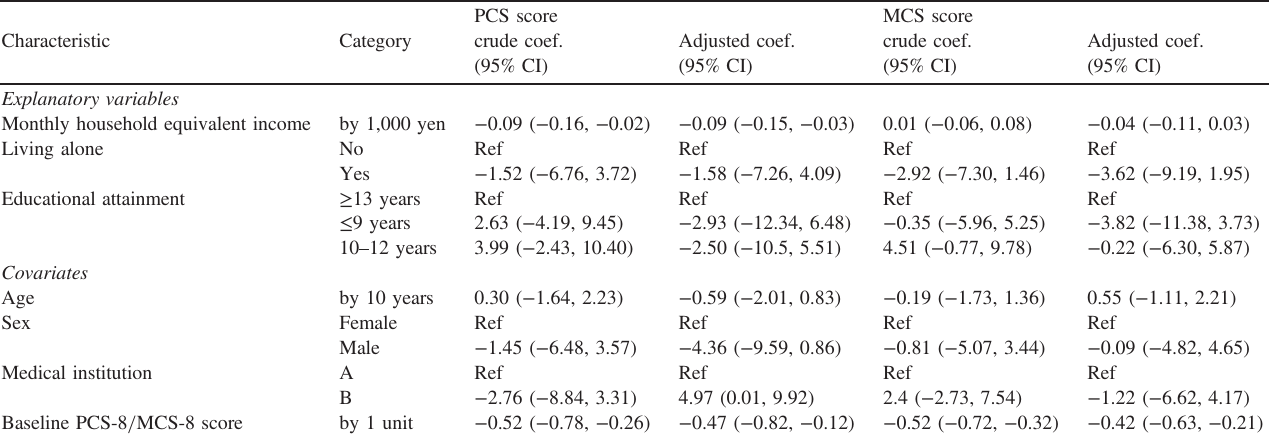
Table 2. Crude and adjusted coe ffi cients and 95% con fi dence intervals for changes in PCS-8 and MCS-8 scores by individual